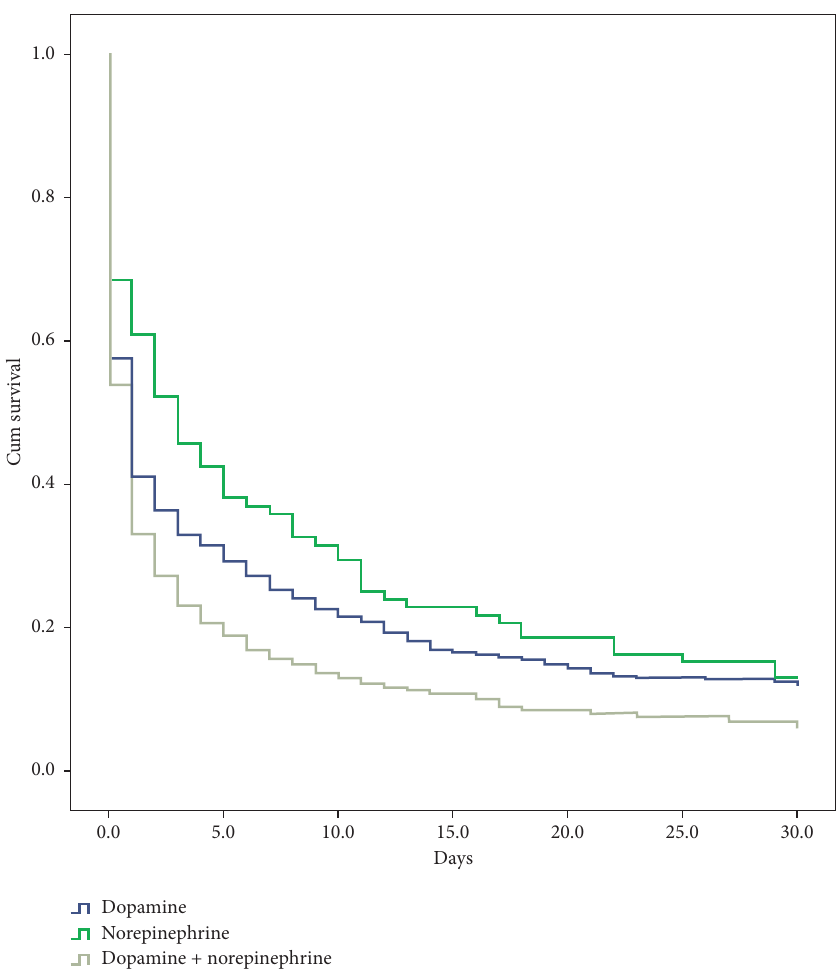
Figure 2: Survival curves of the three treatment groups. Compared with the dopamine treatment group (blue line), the p values were 0.128 (norepinephrine) (green line) and 0.002 (dopamine +norepinephrine) (gray